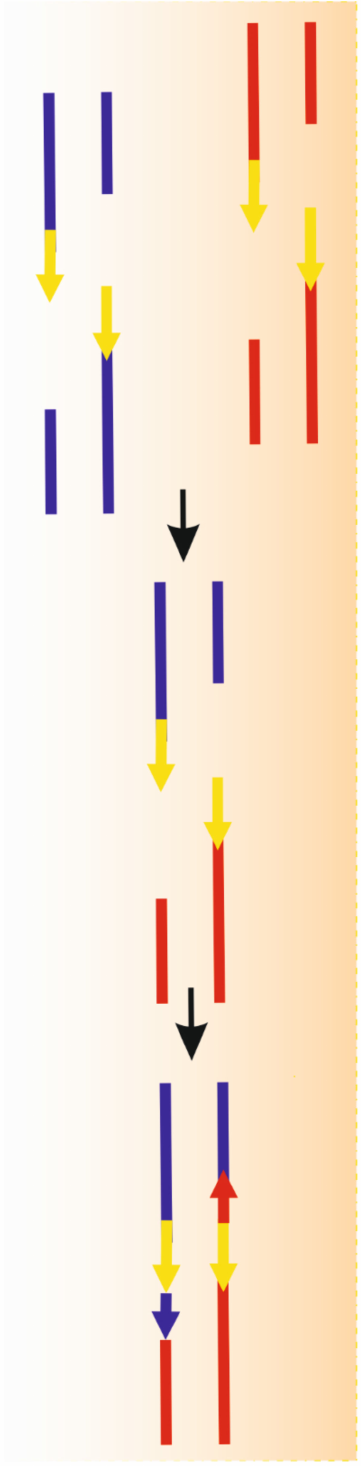
Figure 4. Single-strand annealing (SSA) may induce chromosomal translocations. Different (heterolo- gous) chromosomes may experience double-strand breaks (DSBs) that may be flanked by the same homologous repeats (yellow arrows). SSA machinery may combine repeats from different chromo- somes and produce a fusion chromosome, in which gaps are filled by a DNA polymerase (red and blue arrows) and DNA ligase seals the lacking phosphodiester bond. Protruding non-homologous single-stranded fragments resulting from the annealing process are not